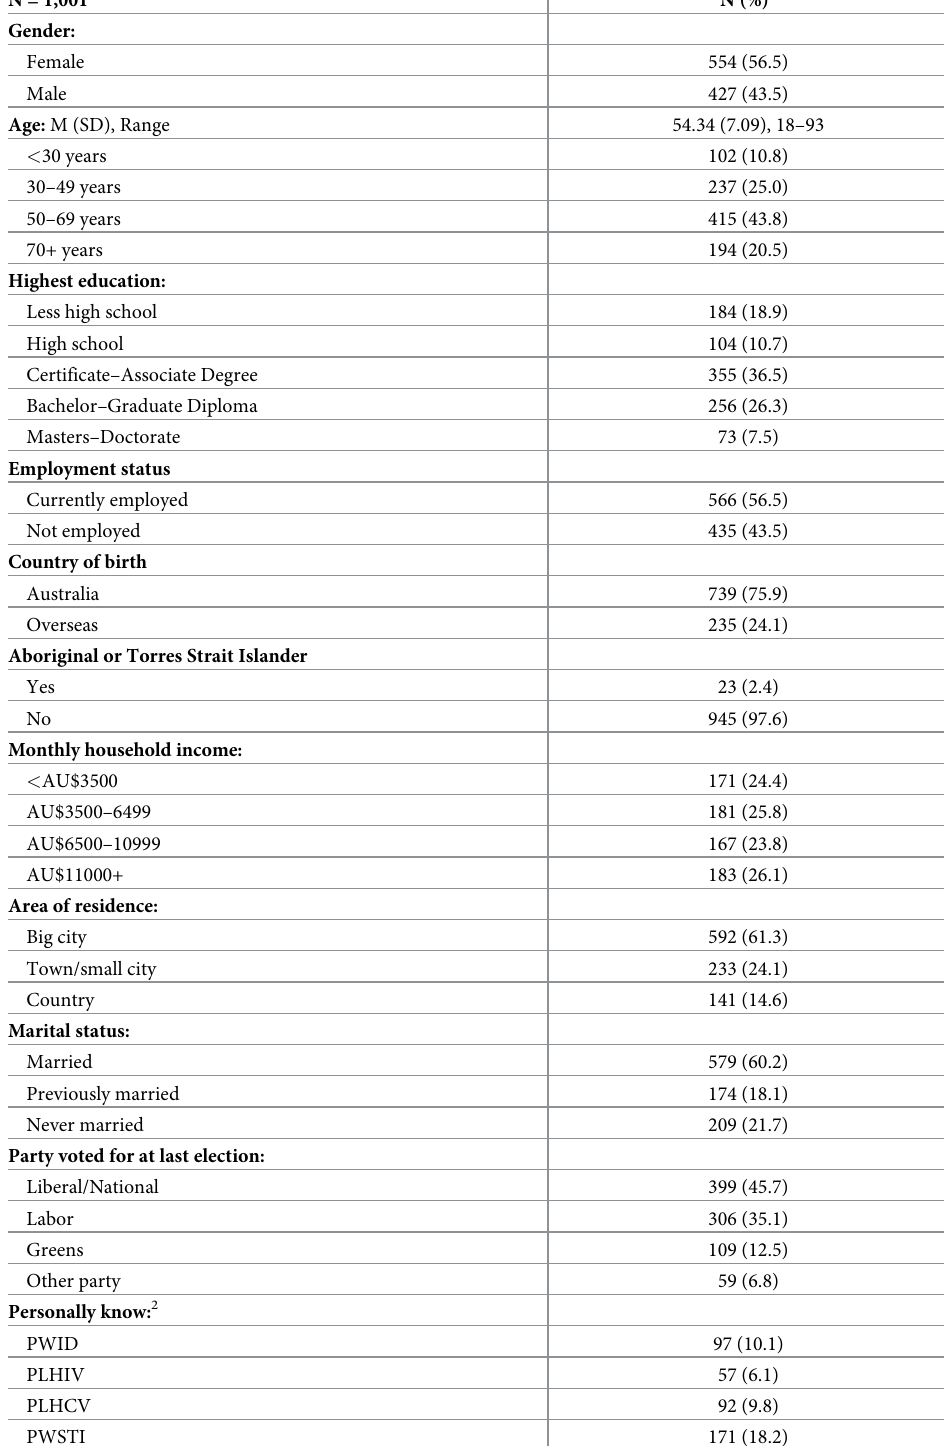
Table 1. Participants’ socio-demographic